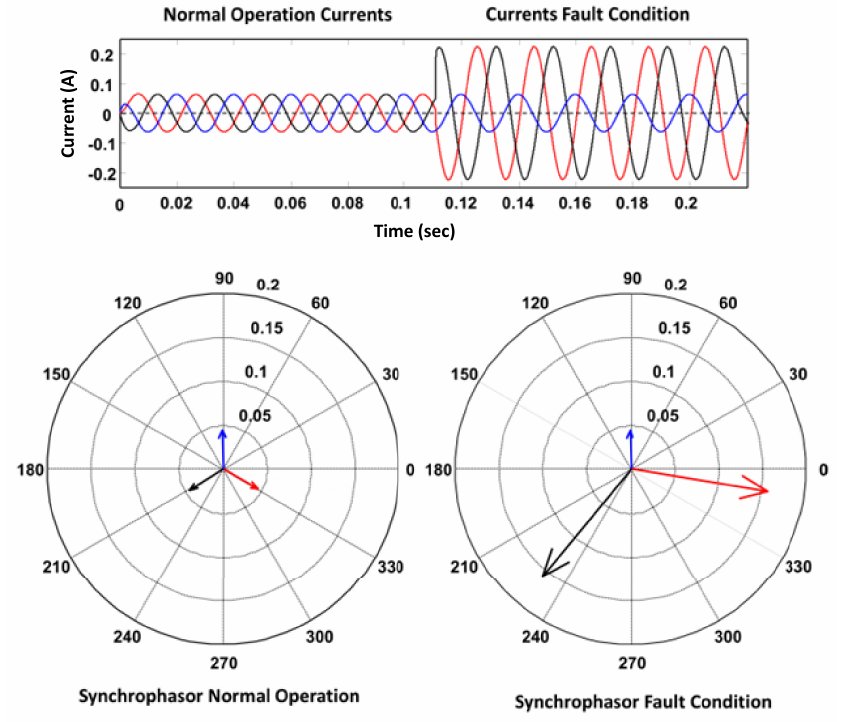
Figure 8. Current waveforms and synchrophasor measurements during normal operation and a fault